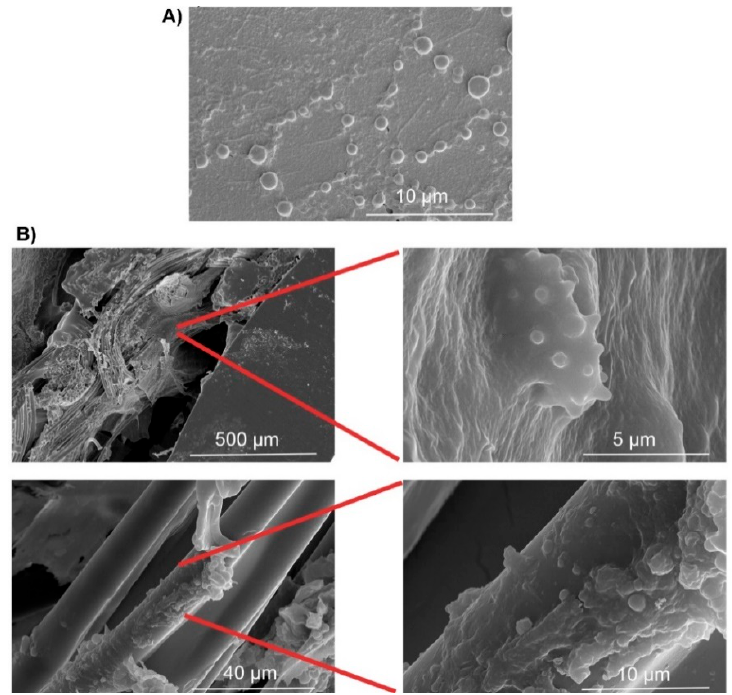
Figure 4. Clinical biofilms observed on an infected VAD driveline [8]. A driveline was explanted from a VAD patient with clinically diagnosed S. aureus driveline infection. The driveline was sectioned into small pieces, washed to remove planktonic cells, structurally fixed with glutaraldehyde, and imaged with scanning electron microscopy. ( A ) S. aureus monolayer biofilms formed on the smooth section of the driveline around the exit-site; ( B ) Microcolony-alike biofilms formed at the tissue-driveline interface (upper panels) or on the velour fibers (lower panels). Reprinted from Reference [8], Copyright (2020), with permission from Elsevier.